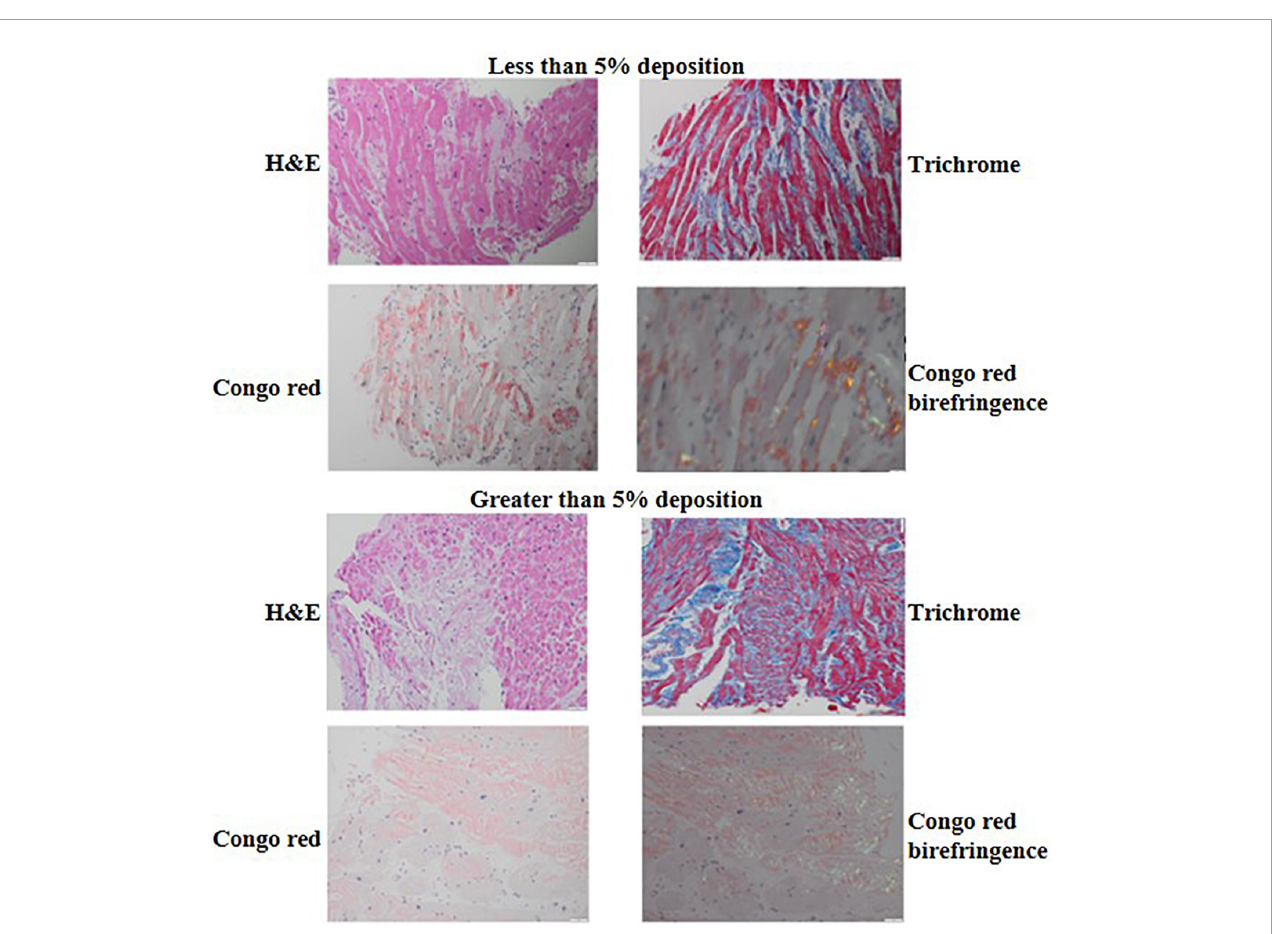
FIGURE2 H&E, trichrome, Congo red and Congo red birefringence appearance of a biopsy sample with < 5% (top) compared to a biopsy sample with ≥ 5% interstitial amyloid deposition (bottom) . The H&E and trichrome photomicrographs were captured using the 20 × lens on 50 µ m scale while the Congo red and Congo red birefringence photomicrographs were captured using the 40 × lens on 20 um